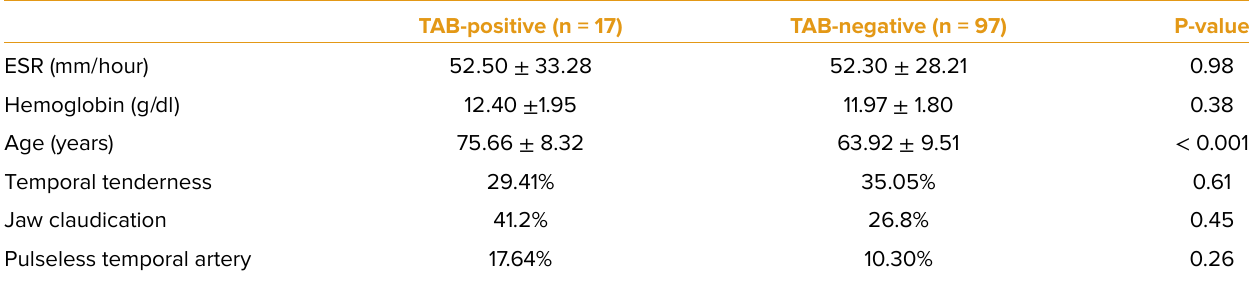
Table 2. Comparison between TAB-negative and TAB-positive patients according to the 2016 revised ACR criteria